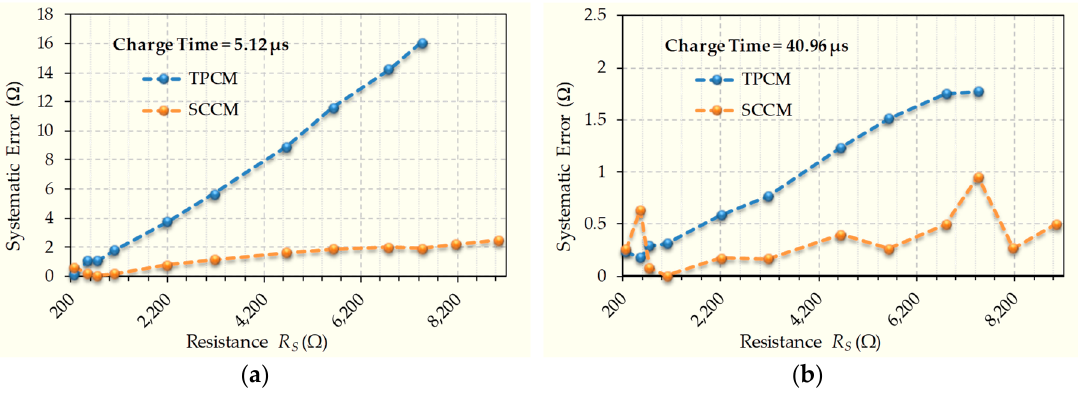
Figure 7. Systematic error for TPCM and SCCM for various charge times. ( a ) Charge Time of 5.12 µs. ( b ) Charge Time of 40.96 µs.